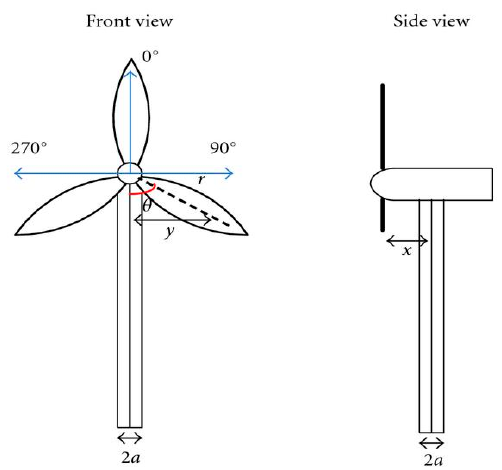
Figure 4. Dimensions used in the tower shadow formula [12].